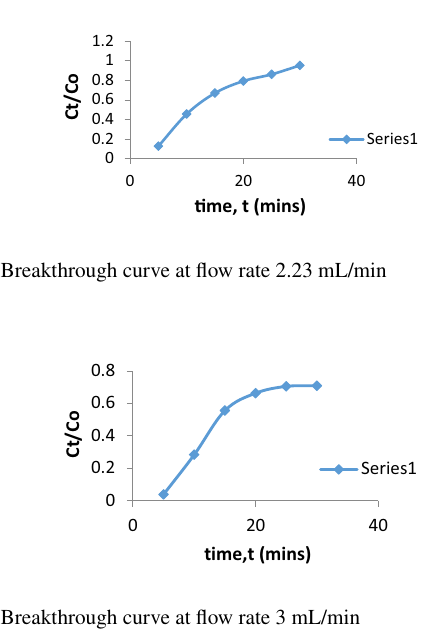
Fig. 7 Breakthrough curve at bed height 7 cm (0.7 g)